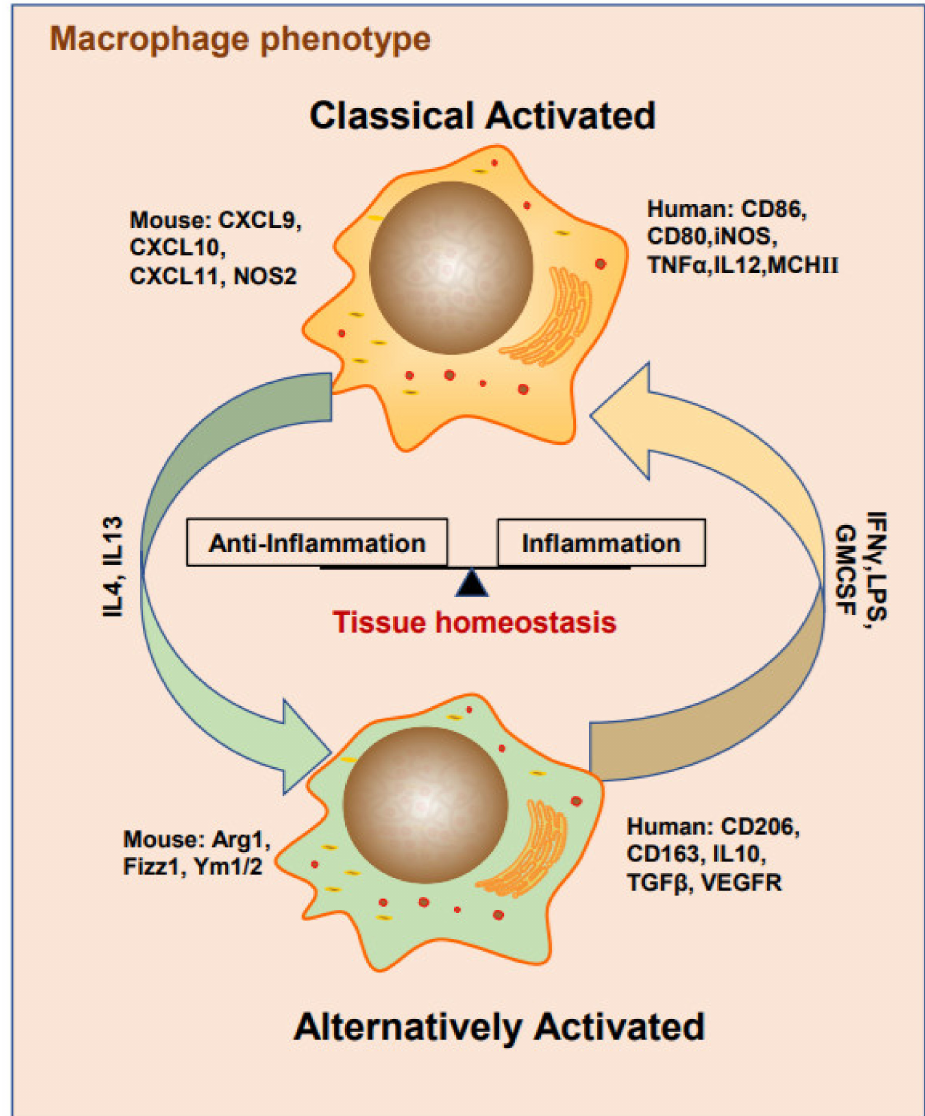
Figure 1. Macrophage M1/M2 polarization status maintains organizational stability. IFN- γ , LPS, GMCSF are the key stimulators of classically activated macrophages (recognized as M1). During the acute inflammation phase, M1 macrophage induces inflammatory responses by expressing cell surface markers to attract immune cells and releasing inflammatory factors. On the other hand, IL4 and IL13 are inducers of alternatively activated macrophages (recognized as M2), which switch the inflammatory response to anti-inflammatory to carry out tissue remodeling